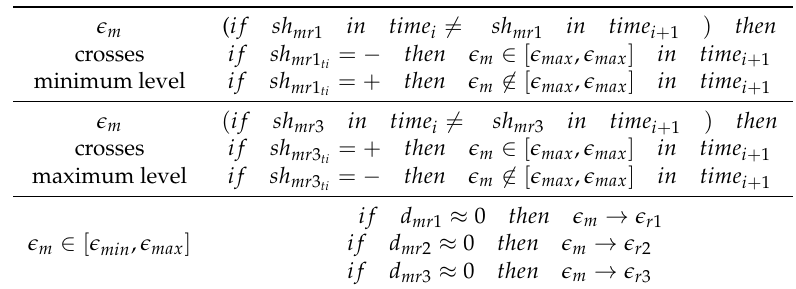
Table 6. Rules Configuration of a sensor microstrip that detect low, medium or high permittivity levels in applications where permittivity must be